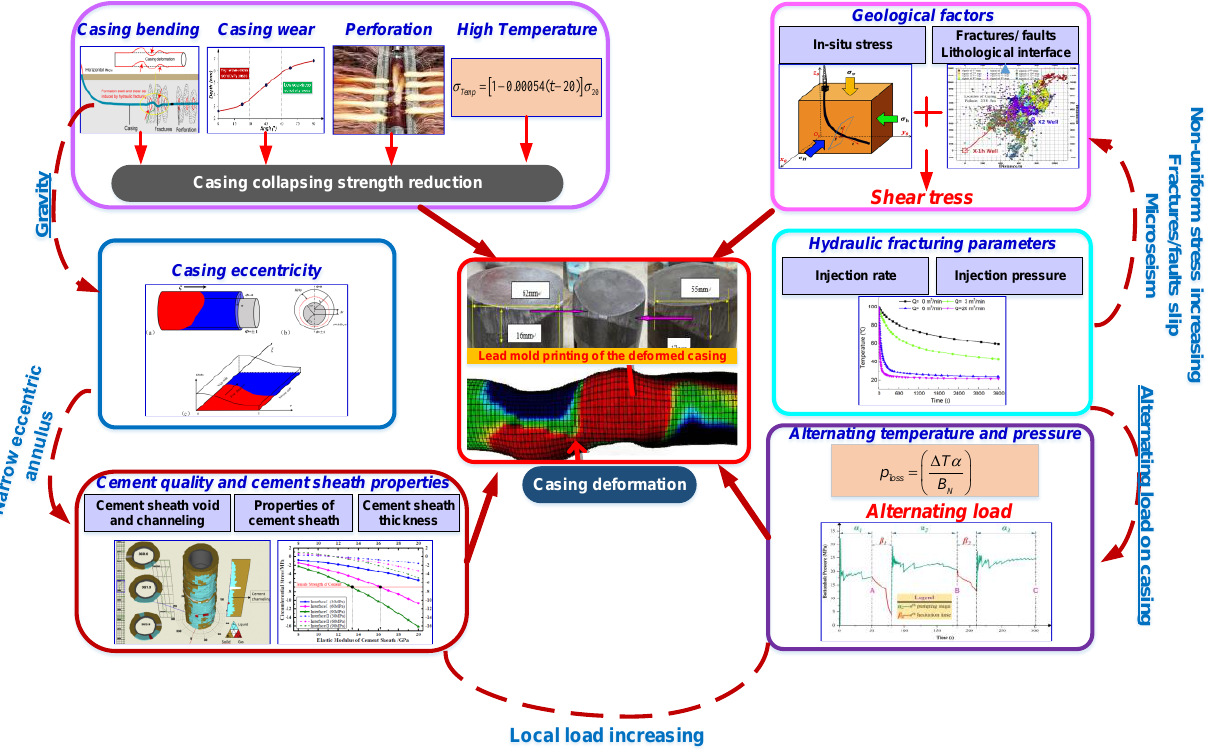
Figure 13. Schematic diagram of the relationship between various influencing factors. Some pictures in this figure from Yu [52], Xi, Li [19], Lian, Yu [31], and Liu, Gao [48].